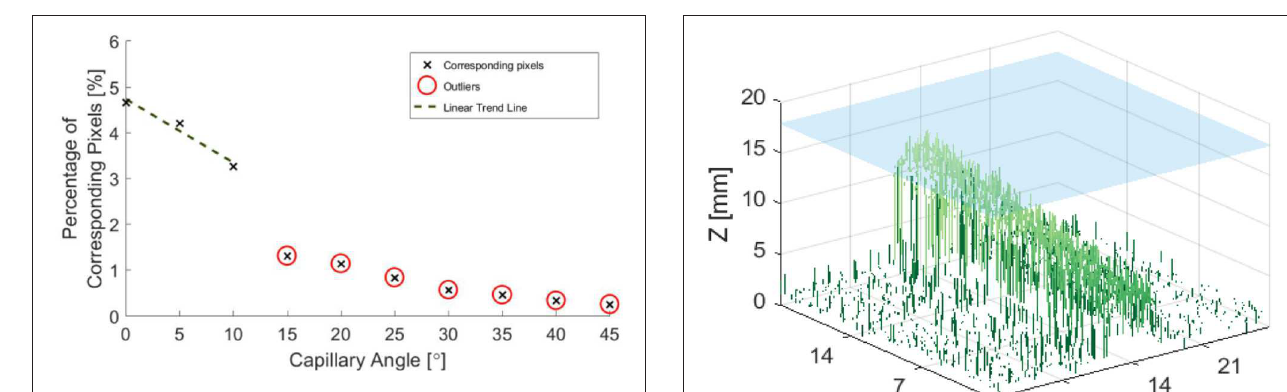
FIGURE 11 | Percentage of pixels for which a corresponding pixel could be found in the partnering stereo image, for controlled incline angles.